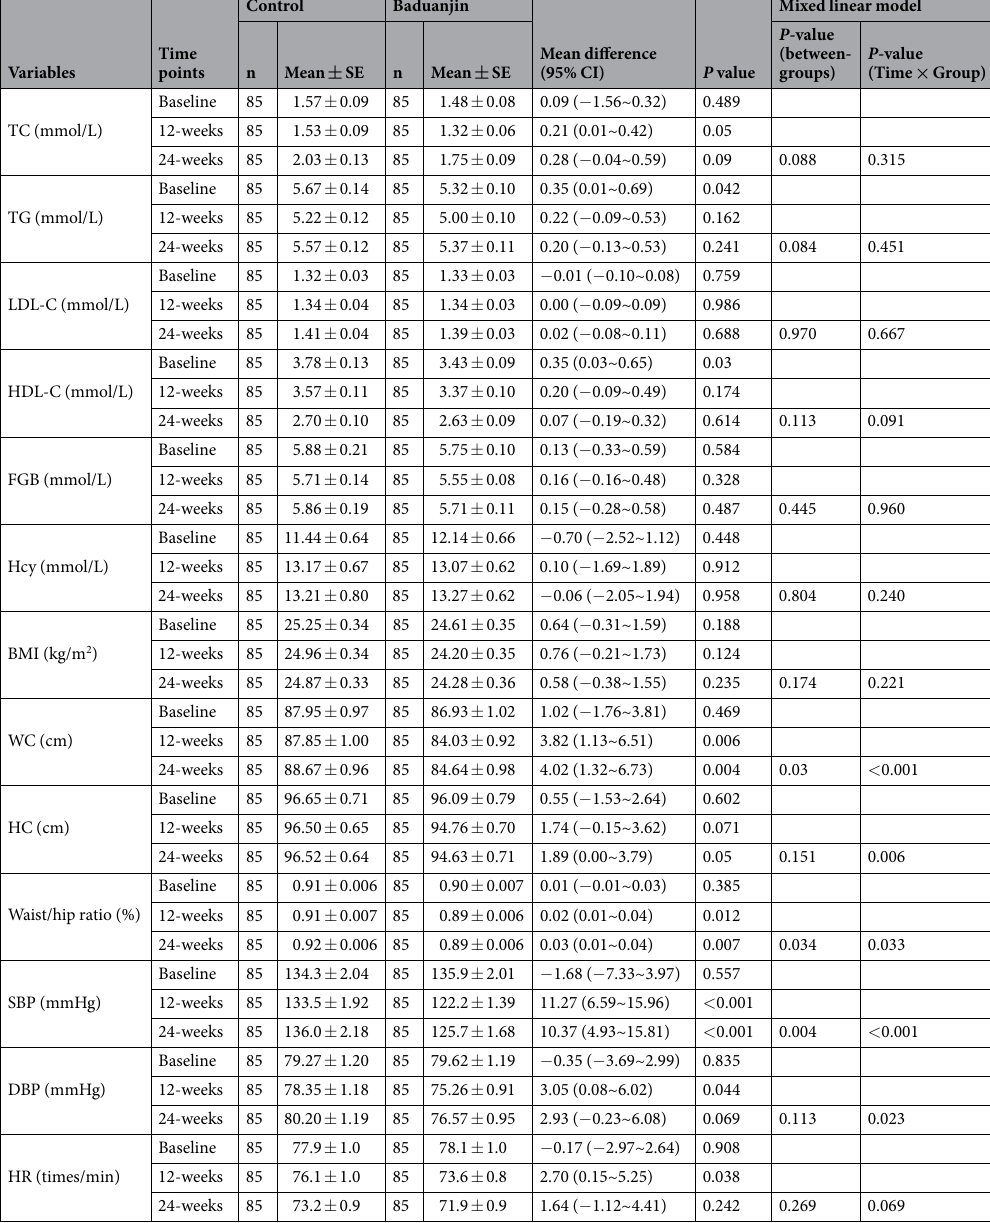
Table 5. The traditional risk factors of cardiovascular diseases at all time points. Abbreviations: TC, Total cholesterol; TG, Triglyceride; LDL-C, Low density lipoprotein; HDL-C, High density lipoprotein; FGB, Fasting blood glucose; Hcy, Homocysteine; BMI, Body mass index; WC, Waist circumference; HC, Hip circumference; SBP, Systolic blood pressure; DBP, Diastolic blood pressure; HR, Heart